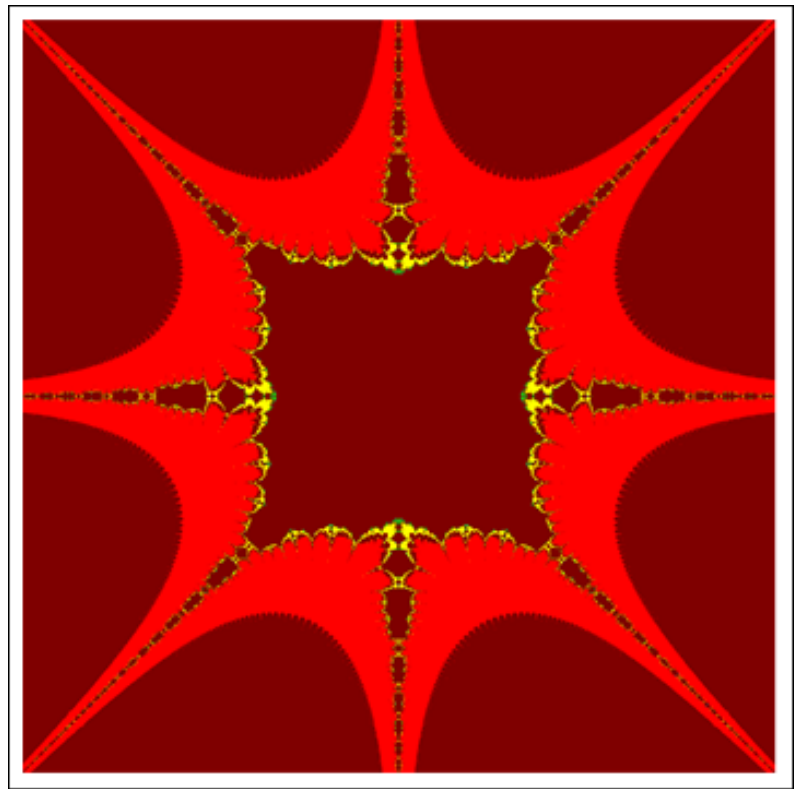
Figure 6. J-set for τ ( z ) = sin ( z 4 ) + c via DKIS. The image execution time is 576.89 s.